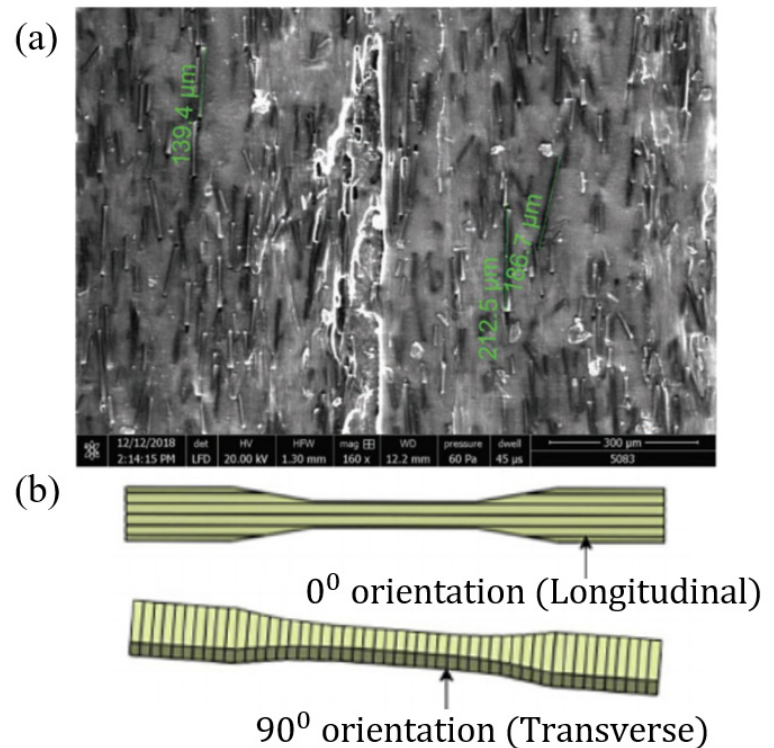
Figure 7. ( a ) Short CF immersed in Nylon matrix (onyx filament) [148]. ( b ) The orientation of the printed tensile specimens [152].